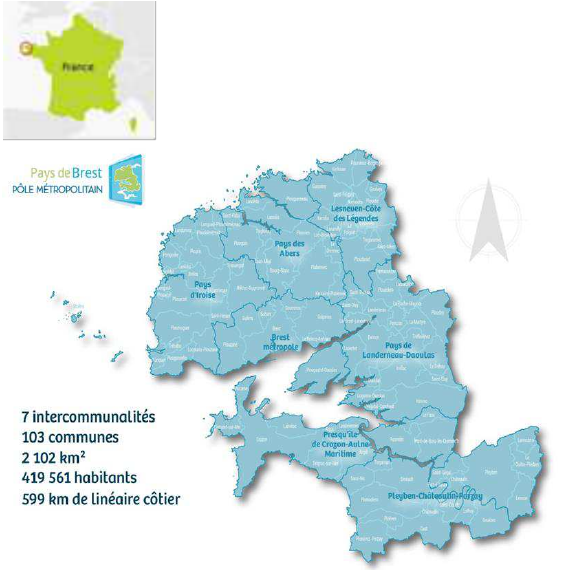
Figure 1. Localization of the Pays of Brest Source :